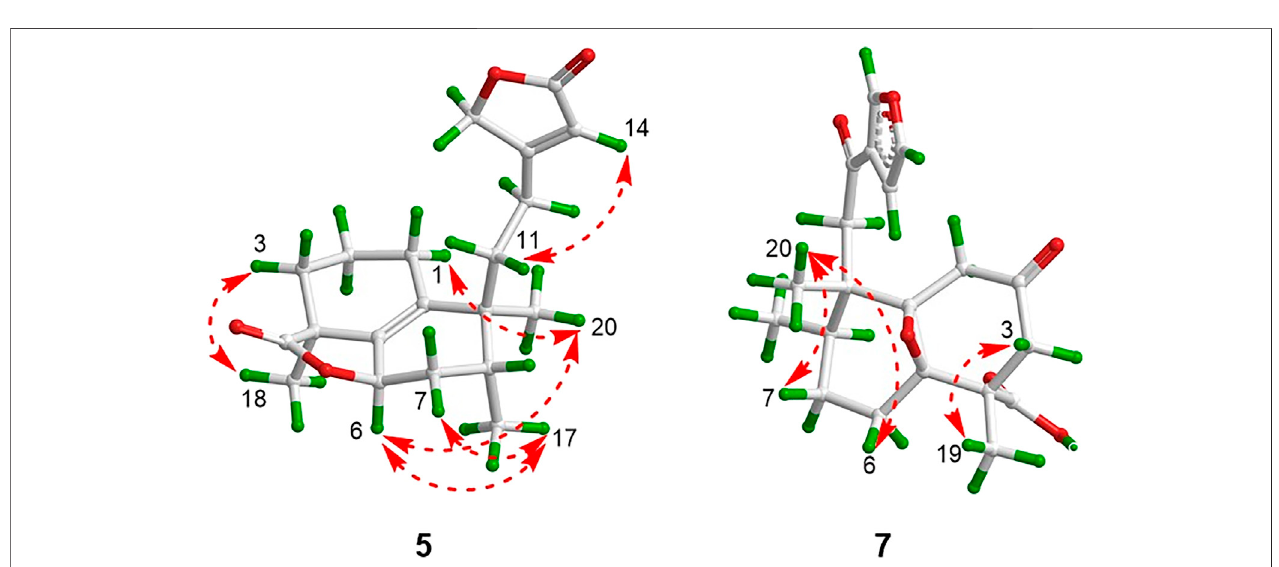
FIGURE 6 | Key NOESY correlations of compounds 5 and 7 .